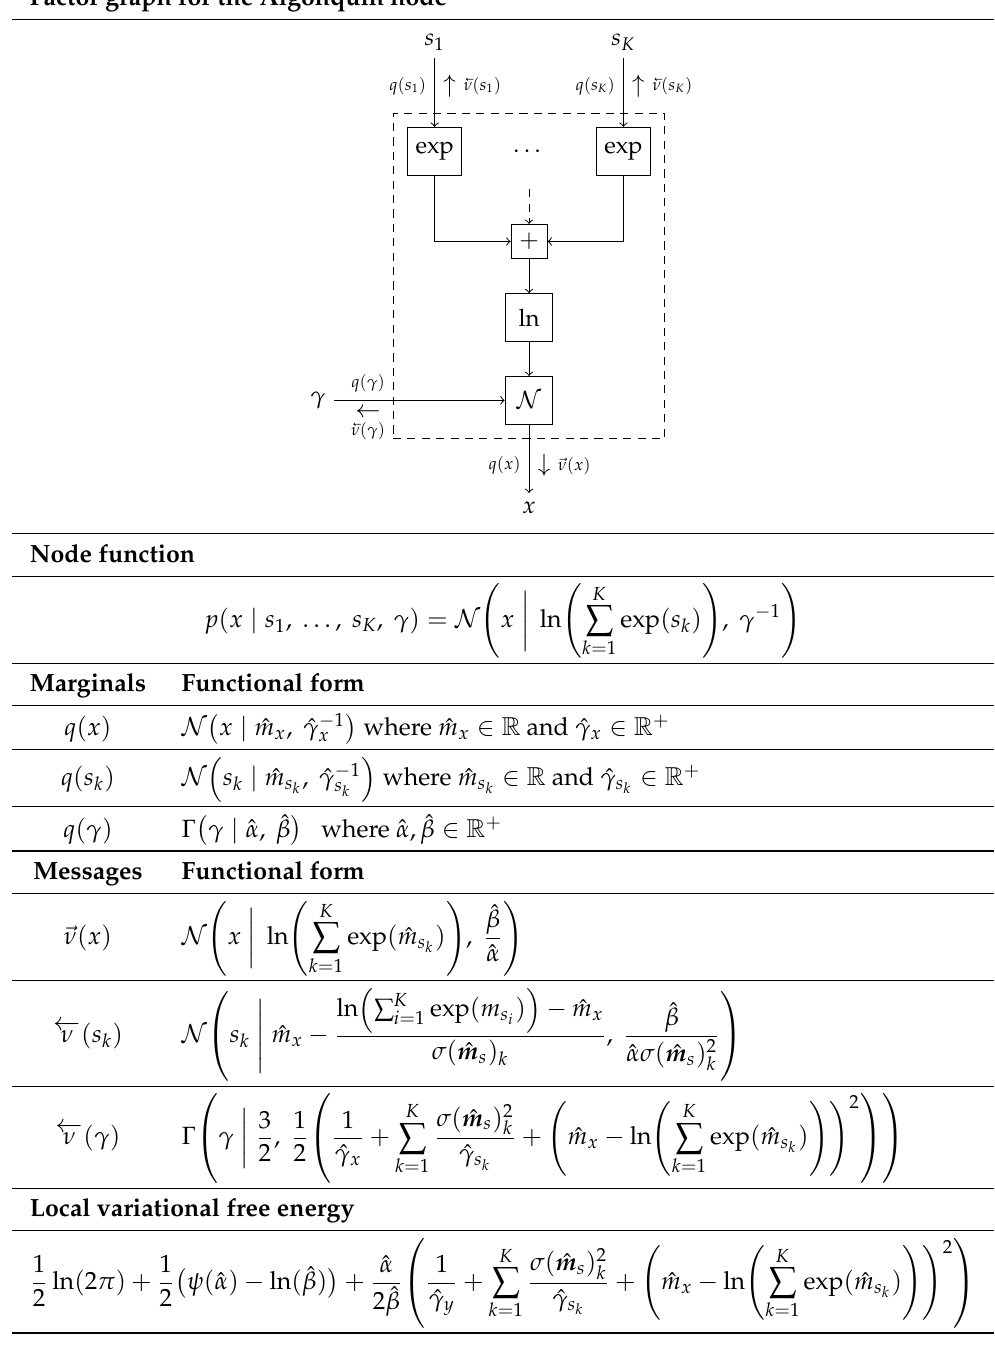
Table 1. Table containing (a) the Forney-style factor graph representation of the generalized Algo- nquin node. (b) The likelihood function corresponding to the generalized Algonquin node. (c) An overview of the chosen approximate posterior distributions. Here the ˆ accent refers to the param- eters of these distributions. (d) The derived variational messages for the generalized Algonquin node. Here the σ ( ) k represents the k th output of the softmax function. (e) The derived local variational free energy, in which ψ ( ) denotes the digamma function. All derivations are avail- able at Supplementary Materials https://github.com/biaslab/SituatedSoundscaping, accessed on 1 July 2021. Factor graph for the Algonquin node